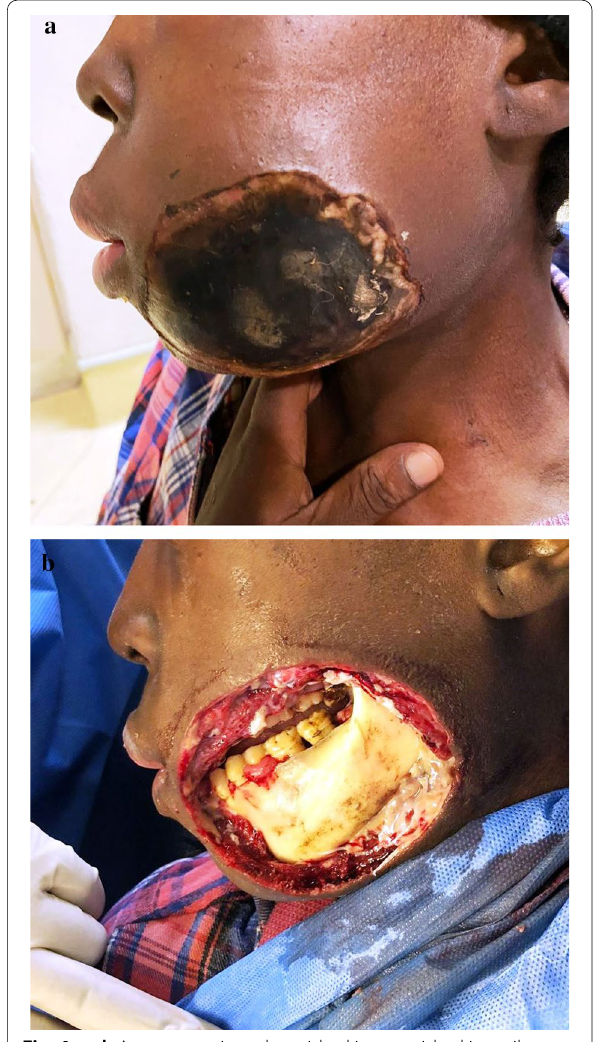
Fig. 4 a , b Acute noma in malnourished impoverished juvenile: ( b ) and the arrested noma shortly after removal of the full-thickness necrotic buccal/facial tissue. Surgical reconstruction poses a major challenge.